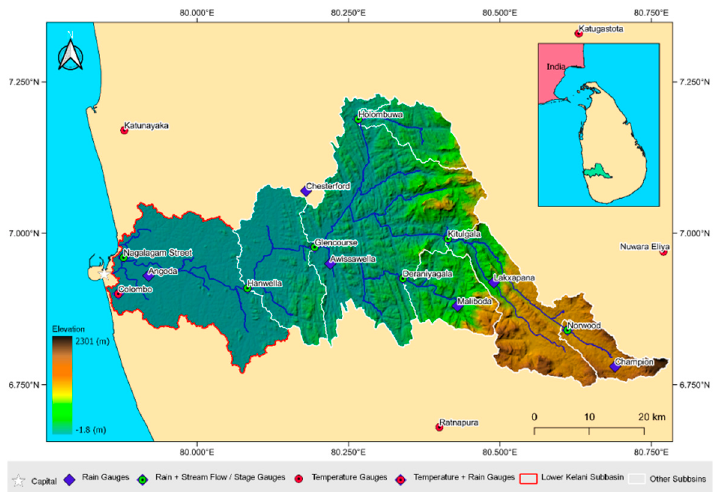
Figure 1. Catchment map of Kelani River Basin (KRB) and the locations of Hydro-Metrological sta- tions.